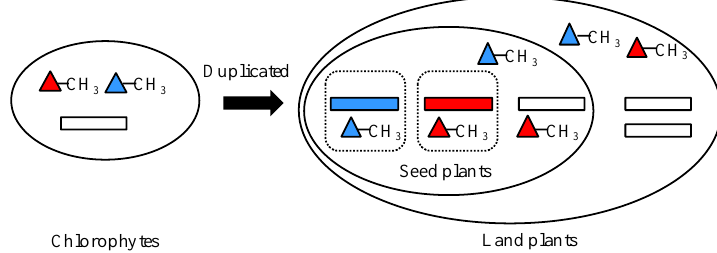
Figure 5. The functional model of HMT genes in plants. The rectangles represent HMT genes. The blue and red rectangles indicate the type 1 HMT genes in expression pattern, while the white rectangles denote other three types: type 2, type 3, and type 4. The blue and red triangles represent methyl donors R , S -SAM and SMM, respectively. The squares in dotted lines indicate different plant organs.